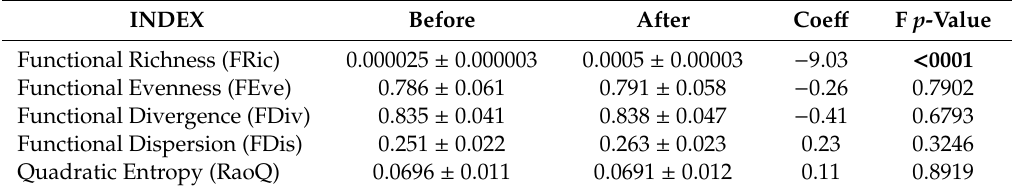
Table 3. Functional diversity indices (mean ± SD), including the F-statistic values respective to the e ff ect of thinning. Functional indices were calculated based on the six traits described in Table 1. INDEX Before After Coe